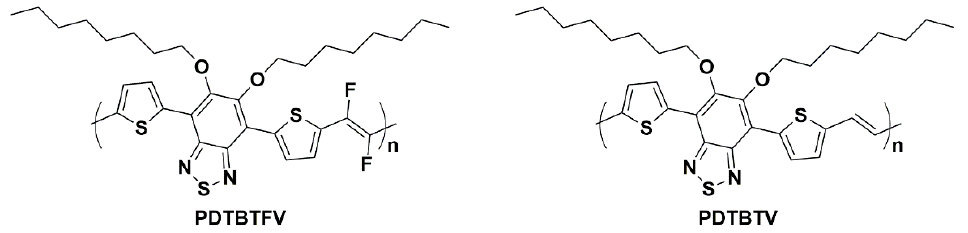
Figure 1. Polymers PDTBTFV and PDTBTV.